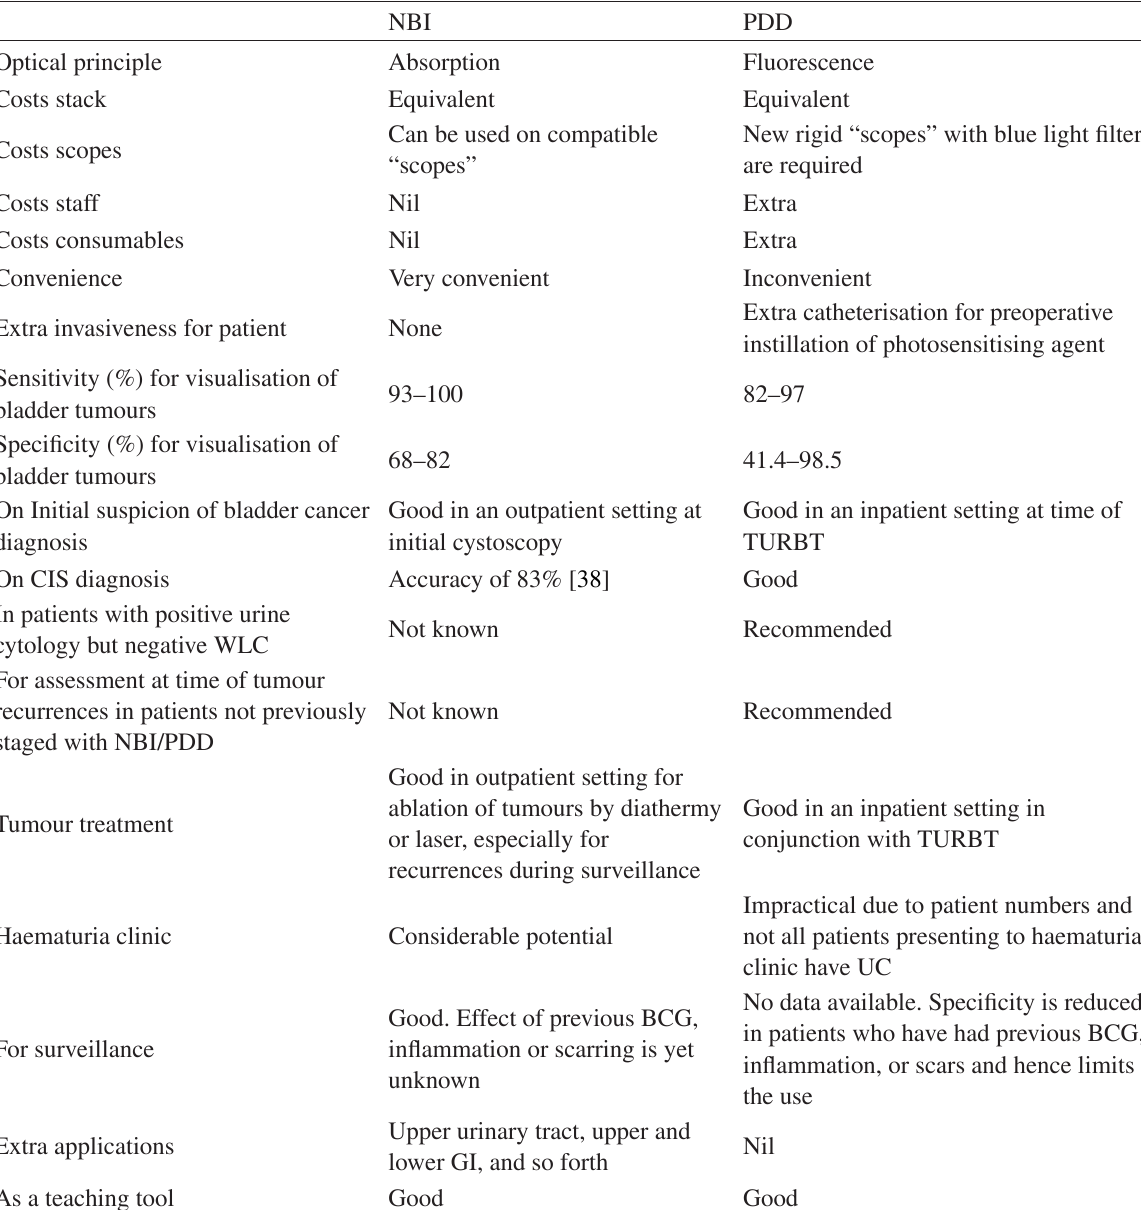
TABLE 1: Overview of NBI and PDD